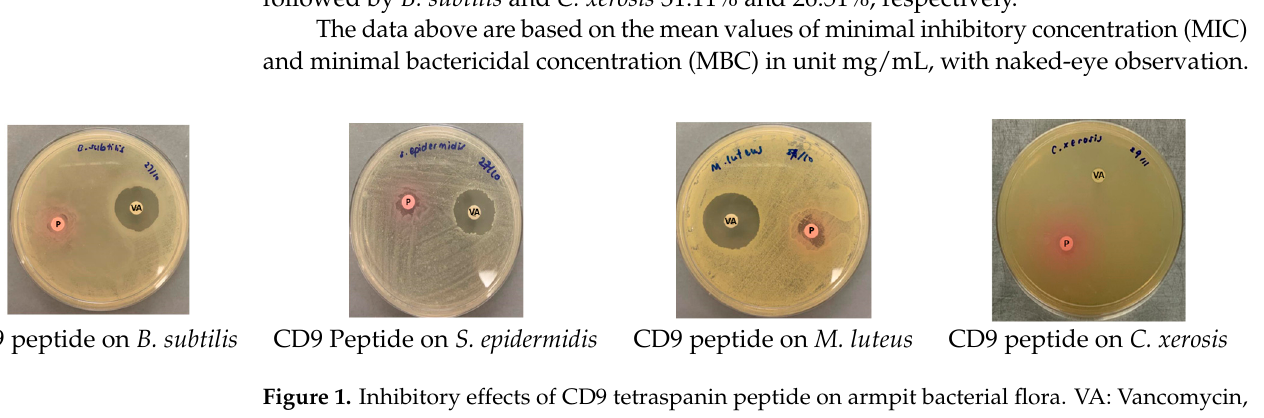
Table 1. Susceptibility of CD9 tetraspanin peptide against armpit bacterial flora.